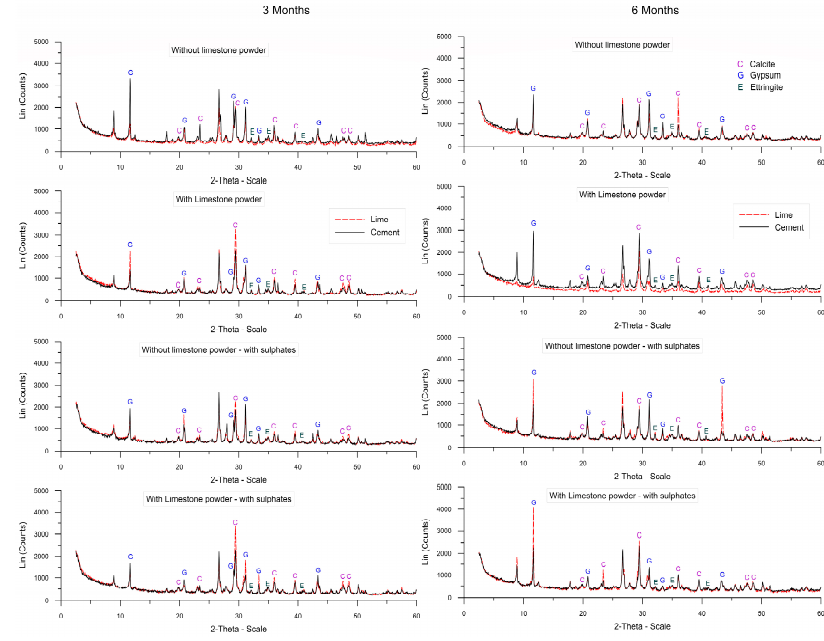
Figure 8. X-ray diffraction analyses of the lime and cement samples at 3 and 6